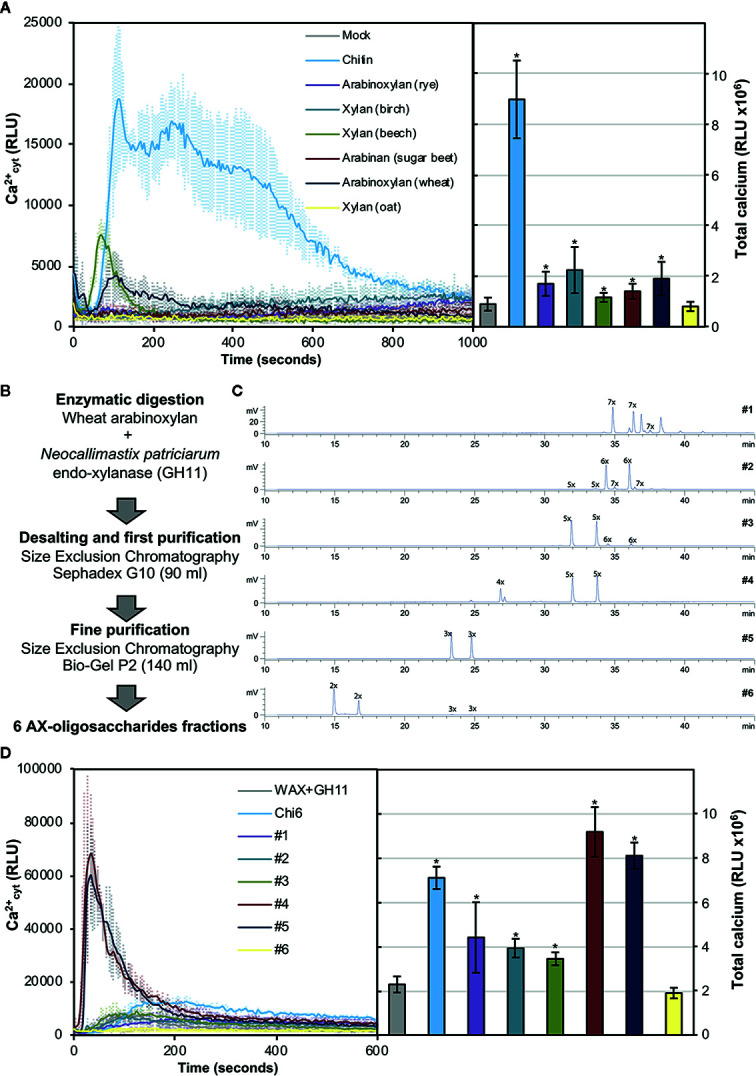
Pentose-based oligosaccharides trigger cytoplasmic calcium elevations. (A) Calcium influx measured as relative luminescence units (RLU) over the time in 8-d old Arabidopsis Col-0AEQ seedlings after treatment with 0.5 mg/ml of chitin and arabino-xylan polysaccharide preparations. The total areas-under-the-curves were integrated and their values are represented at the right side of the panel. Data represent mean ± SD (n=8) from one experiment representative of three independent ones with similar results. Statistically significant differences according to Student’s t-test (*p<0.05) compared to negative control (mock) are shown. (B) Preparation and fractionation pipeline of pentose-based oligosaccharides from wheat arabinoxylan (AX). (C) HPLC-ELSD chromatograms of purified oligosaccharide preparations. Peaks are labeled as nX, where “n” correspond to the number of pentoses contained. Double peaks correspond to alpha-/beta-anomeric isomers at the reducing end of each detected oligosaccharide. (D) Calcium influxes after treatment with 0.5 mg/ml of the GH11-digested wheat AX before chromatographic purifications (WAX+GH11), chitohexaose (Chi6) and the purified pentose-based oligosaccharides (#1–6). The total areas-under-the-curves were integrated and their values are represented at the right side of the panel. Data represent mean ± SD (n=8) from one experiment representative of three independent ones with similar results. Statistically significant differences according to Student’s t-test (*p < 0.05) compared to negative control (WAX+GH11) are shown.